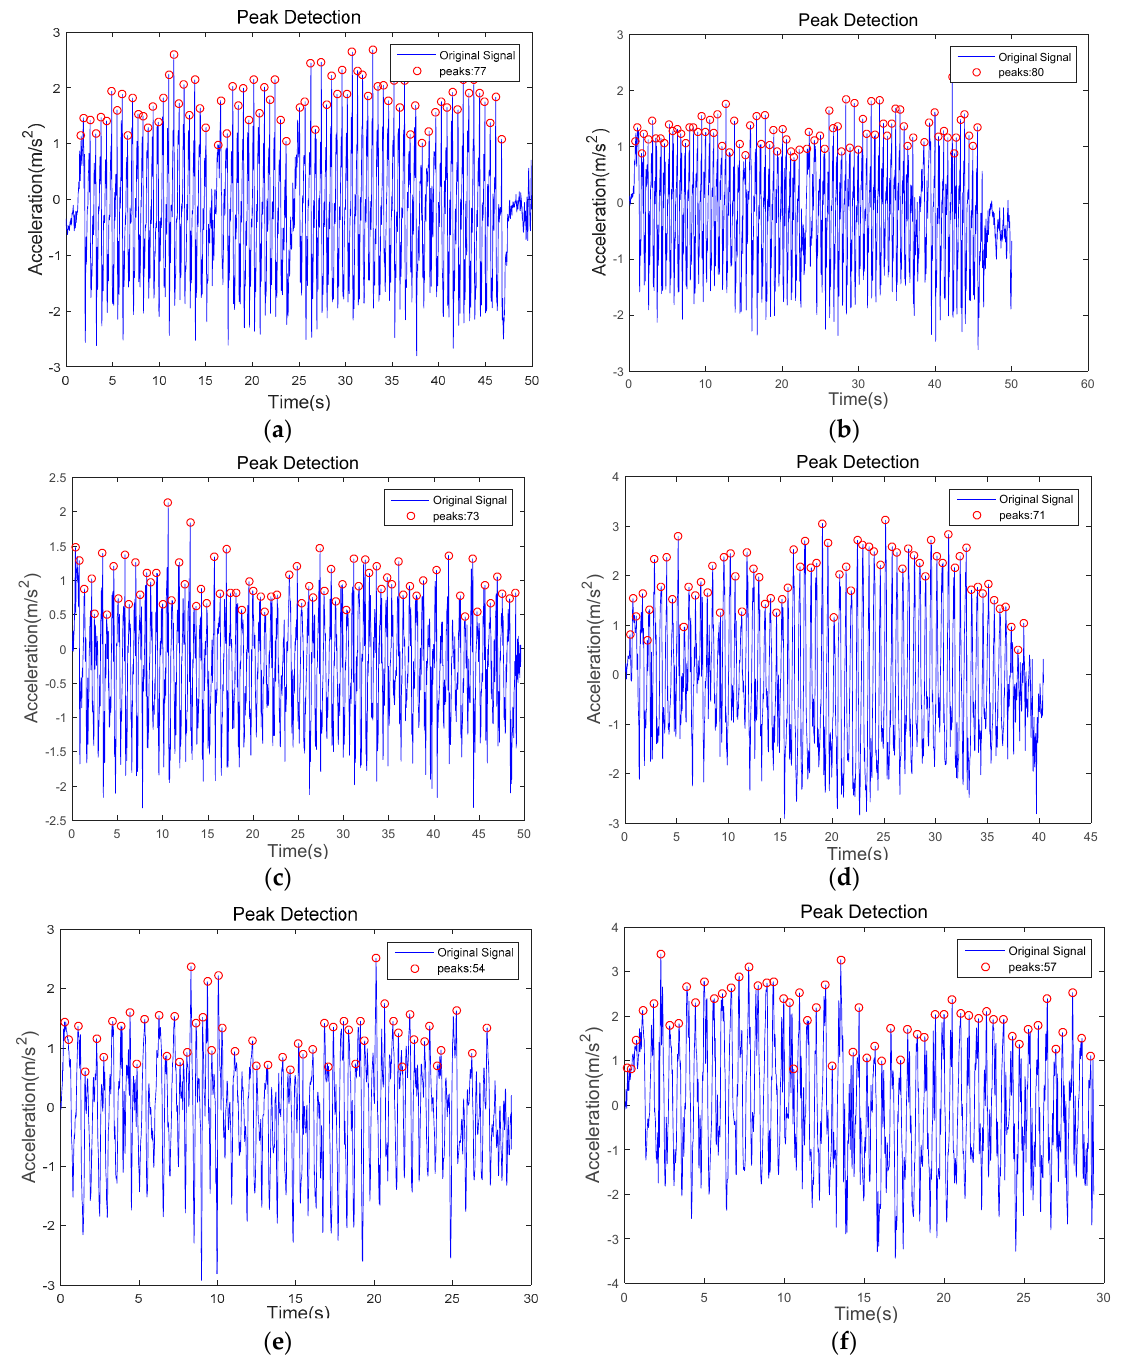
Figure 11. Step detection result of six volunteers: ( a – f ) are the detected steps for each volunteer, ( a ) F1 (Zhu); ( b ) F2 (Zhou); ( c ) M1 (Guo); ( d ) M2 (Liu); ( e ) M3 (Liu); ( f ) M4 (He).